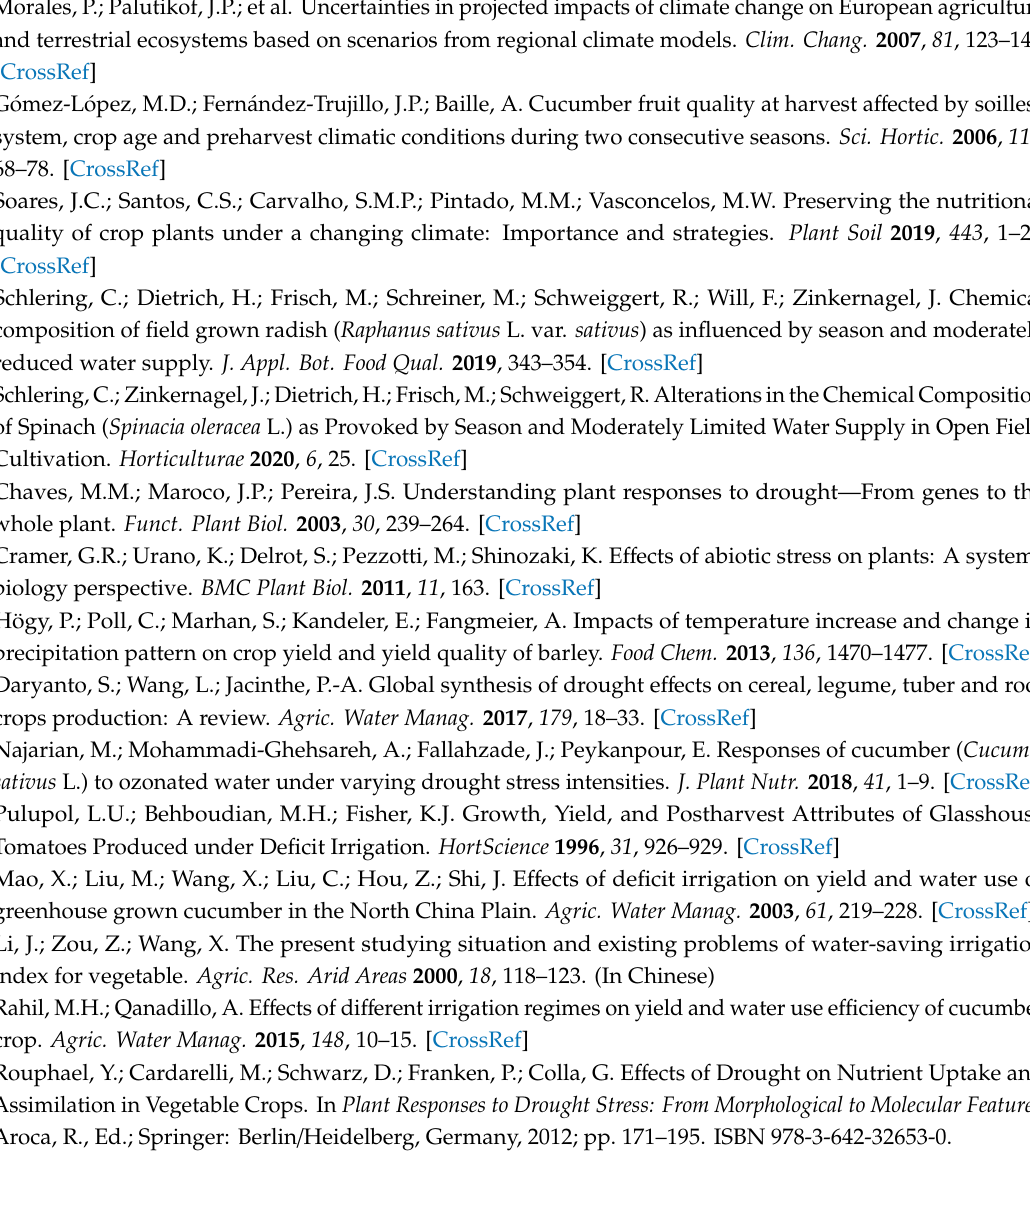
Figure S1: Daily mean weather conditions during the cultivation period of pickling cucumber in open field cultivation in 2016: (A) Mean air temperature ( ◦ C), (B) Global radiation sum (W / m 2 ), (C) Daily mean relative humidity (%), and (D) Daily mean evapotranspiration (mm); DAT = Days After